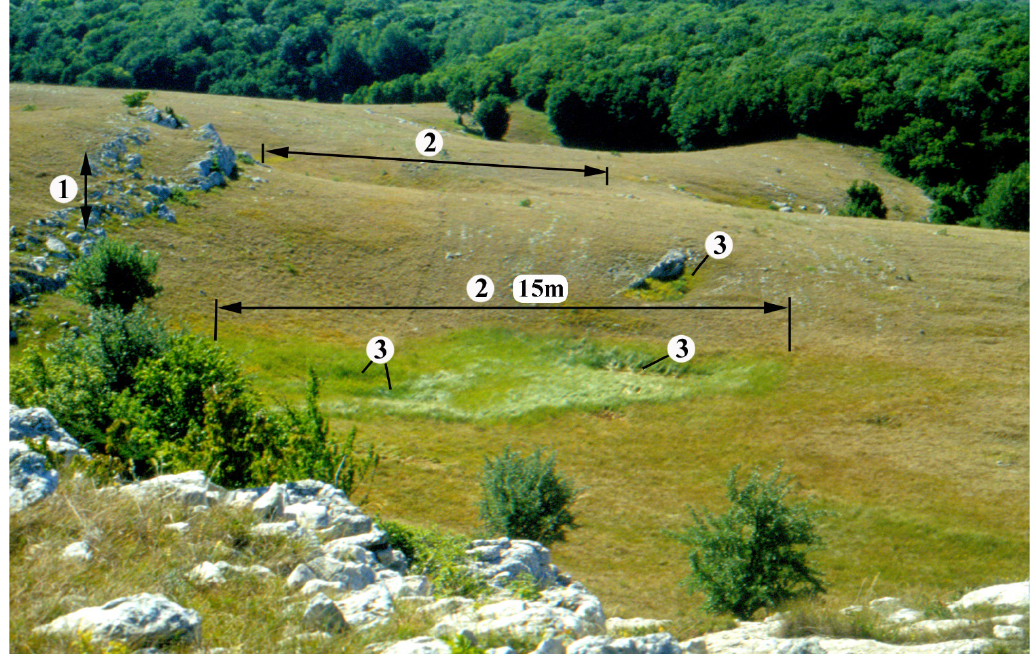
Figure 14. Subsidence dolines of cuesta terrain (Crimean Peninsula). 1. cuesta, 2. solution doline, 3. susidence doline.